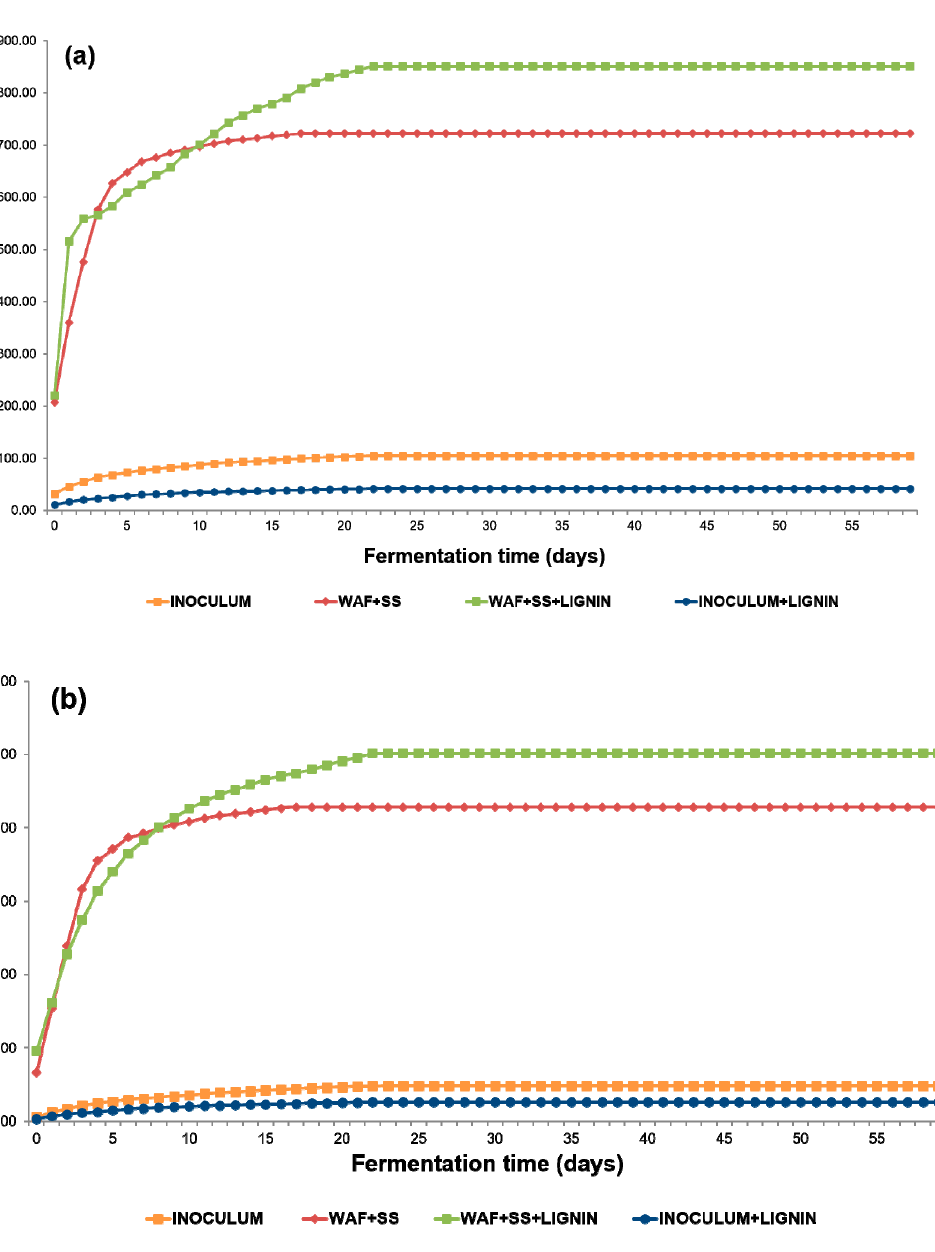
Figure 12. Cumulative biogas ( a ) and methane ( b ) production curves from VS of the WAF+SS WAF + SS + Lignin, Inoculum, Inoculum + Lignin samples.